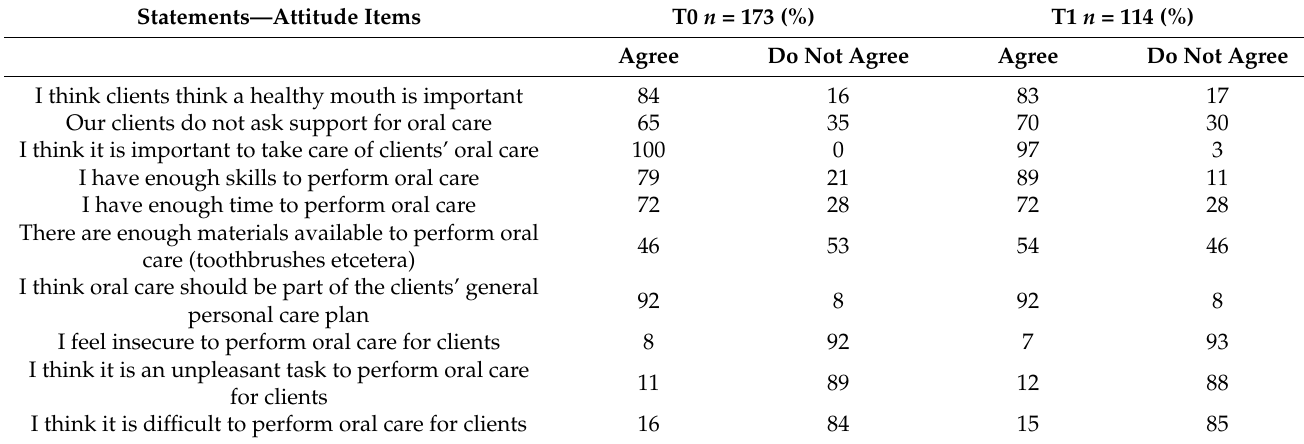
Table 1. Completed attitude statements by HCNs at t0 and